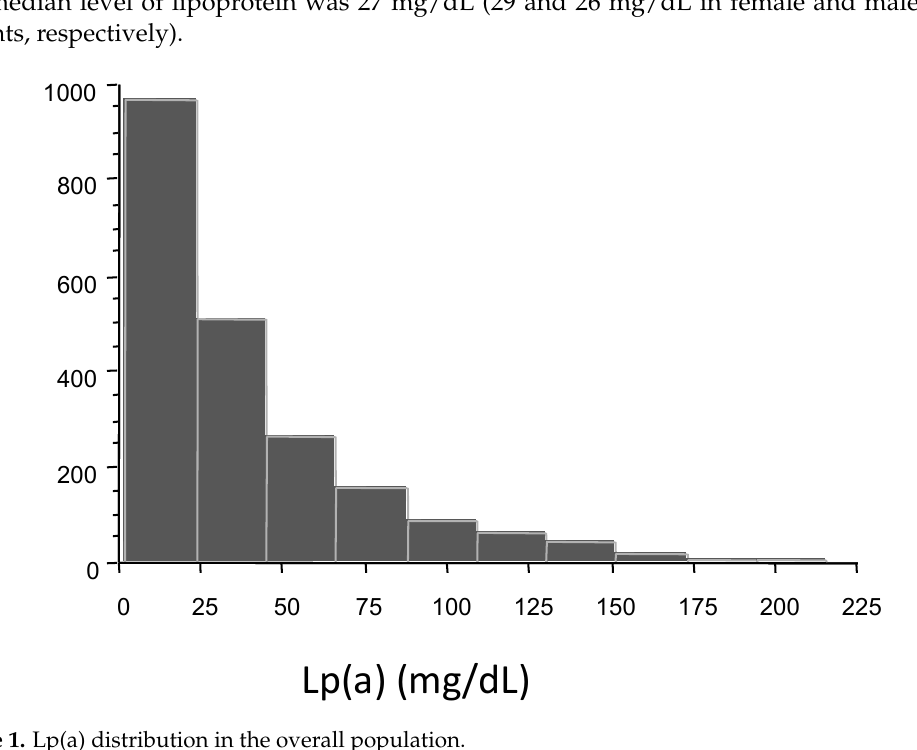
Figure 1. Lp(a) distribution in the overall population. In both sexes, the percentage of subjects with increased Lp(a) (cut-off of 30 mg/dL) differed depending on the presence of dyslipidemia (40 vs. 51%, p < 0.05 and 35 vs. 47%,